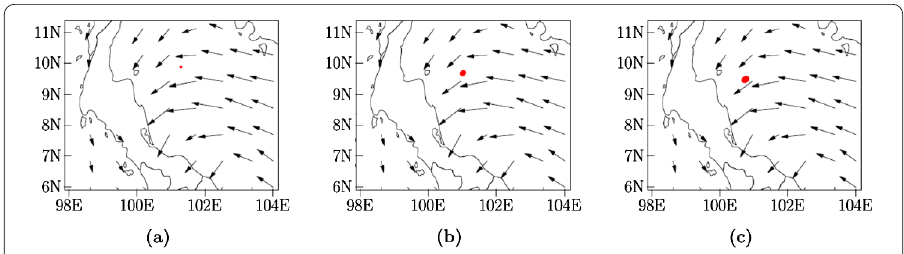
Figure 4 Movement of oil at Platong. The movement of oil slick (red dots in elliptical shape) at Platong oil drilling rig. ( a ) at the beginning of incident, ( b ) 30 minutes later, and ( c ) 60 minutes later.